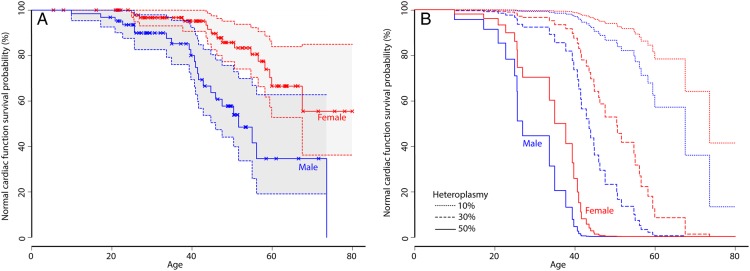
Normal cardiac function survival probability according to gender and blood heteroplasmy. (A) Normal cardiac function survival probability (survival function) for males (blue) and females (red). Censored data (i.e. patients who have not developed cardiomyopathy at their most recent clinical assessment) are shown as crosses, normal cardiac functions are shown as solid lines with 95% confidence intervals. The age for developing cardiomyopathy in males is significantly younger than females (P = 0.0143). (B) Normal cardiac function survival probability (survival function) for males (blue) and females (red) with varying levels of blood heteroplasmy (10% dotted lines, 30% dashed lines, 50% solid lines).